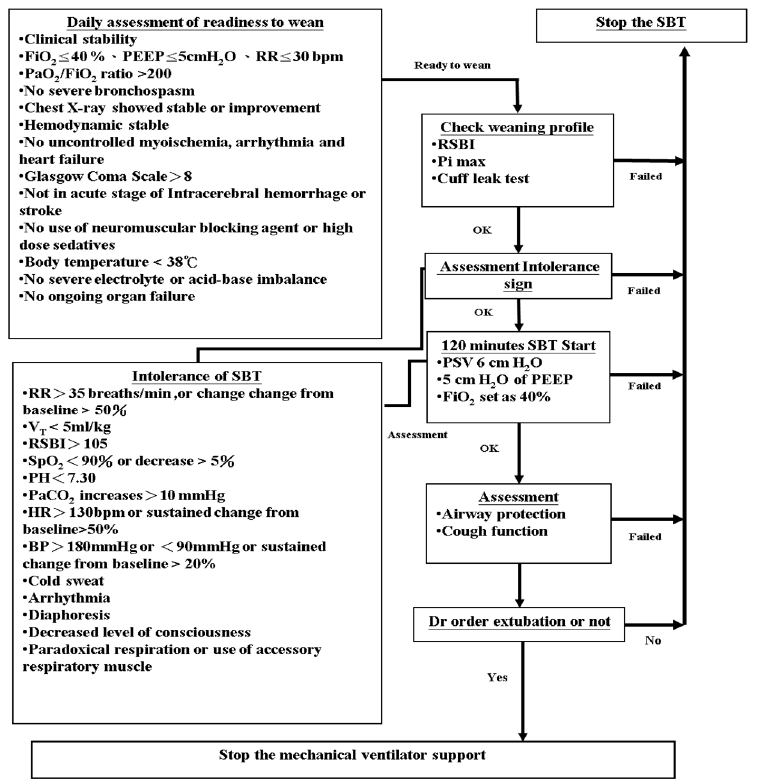
Figure 1. Ventilator weaning protocol in ICU of Kaohsiung Medical University Chung-Ho Memorial Hospital.